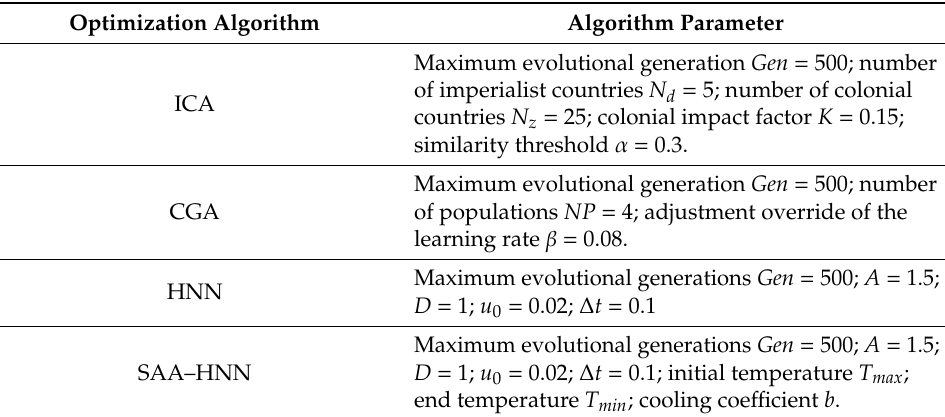
Table 4. Swarm evolutionary algorithm